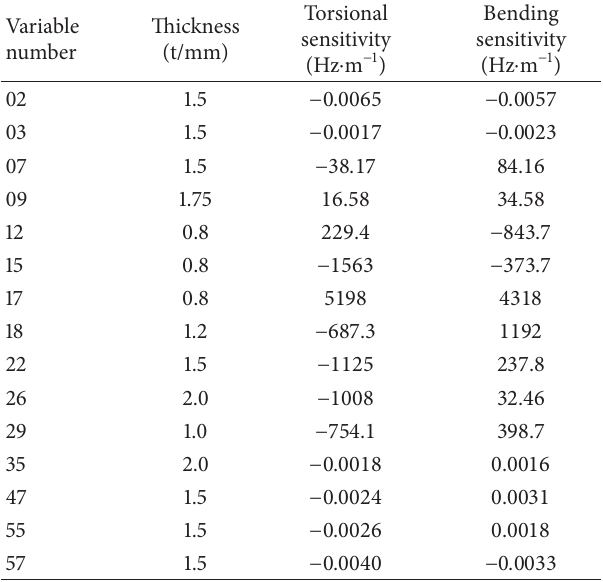
Table 3: The mode sensitivity of main parts